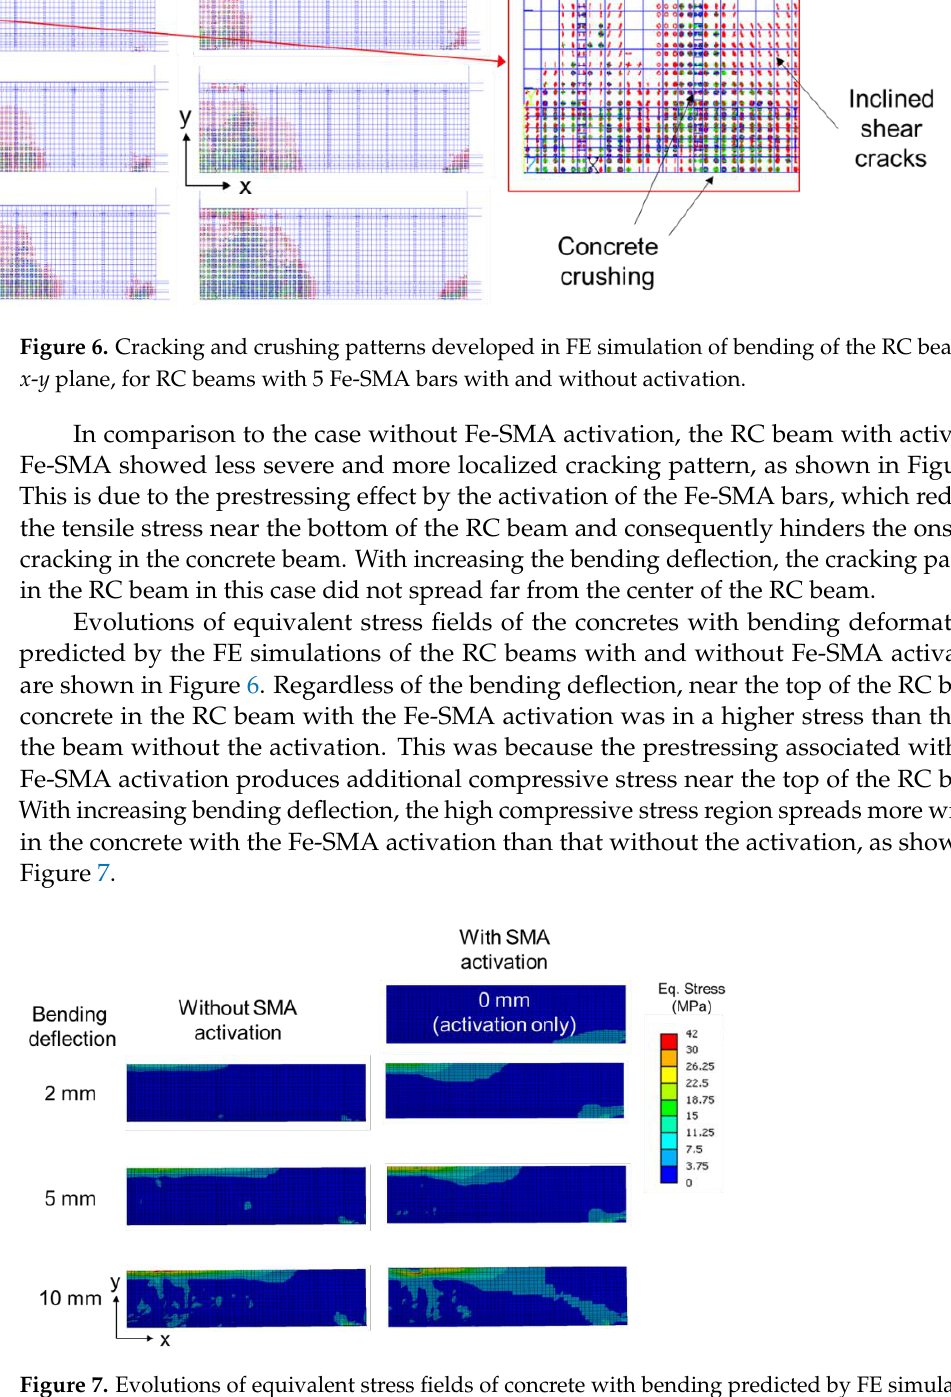
Figure 7. Evolutions of equivalent stress fields of concrete with bending predicted by FE simulations of RC beam with 5 Fe-SMA bars with and without activation.